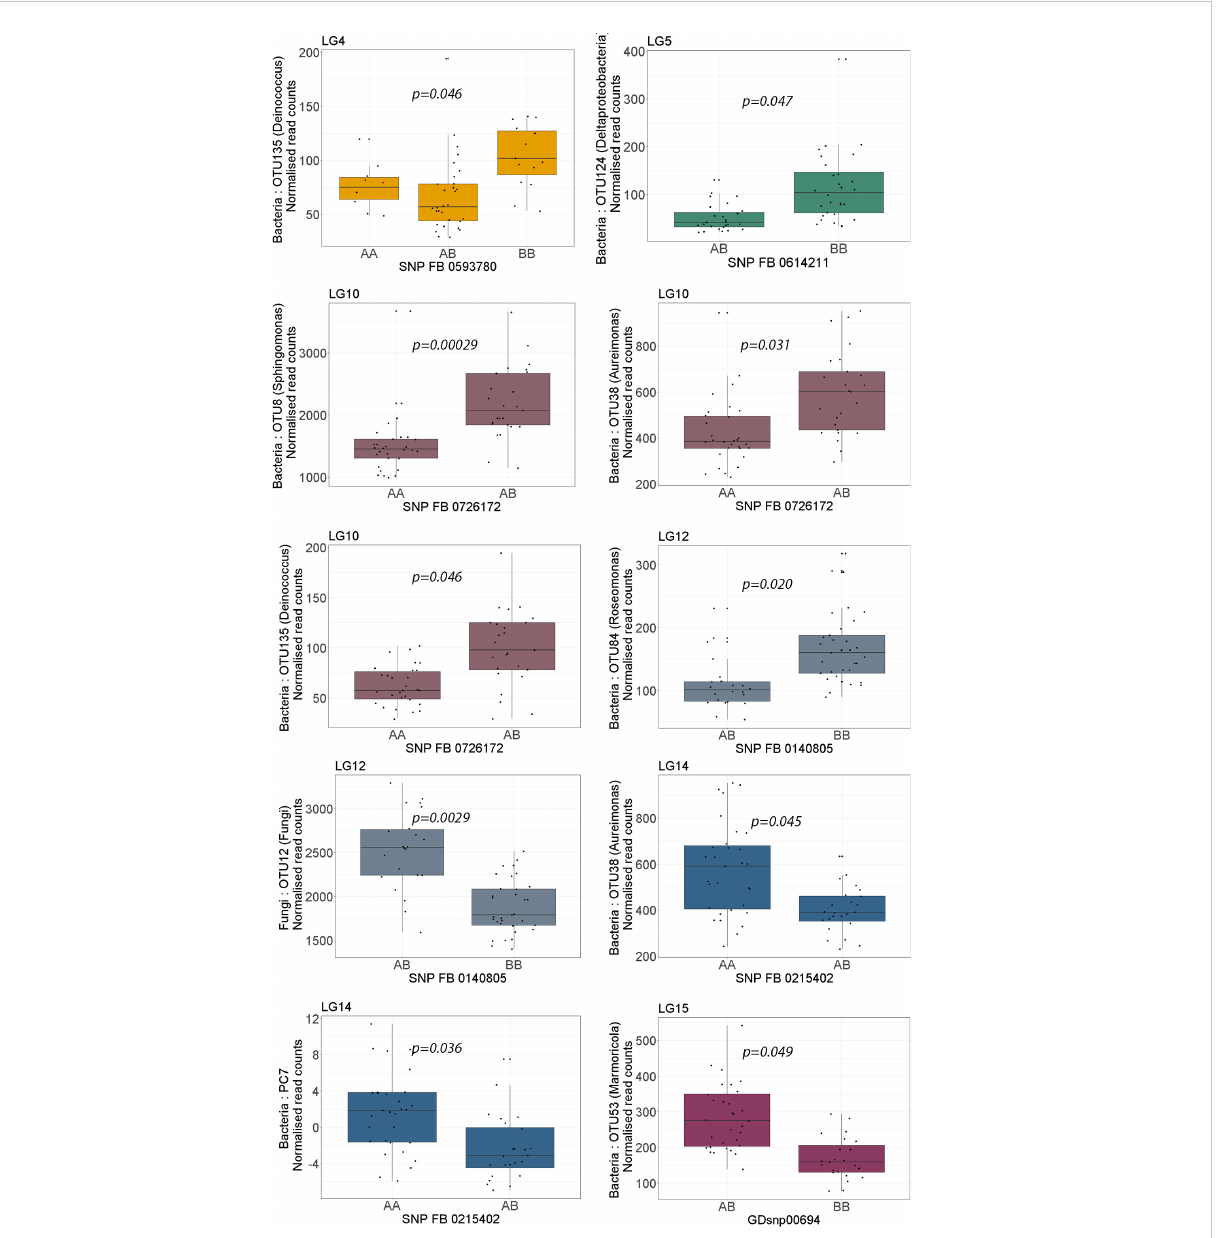
FIGURE 2 Boxplots showing the effect of phenotypic variation between SNP marker genotypes linked to QTLs for endophyte abundance. Kruskal-Wallis test was used to determine the signi fi cant differences between the mean values of SNP genotypes. Graph colour indicates the respective linkage group (LG) of the